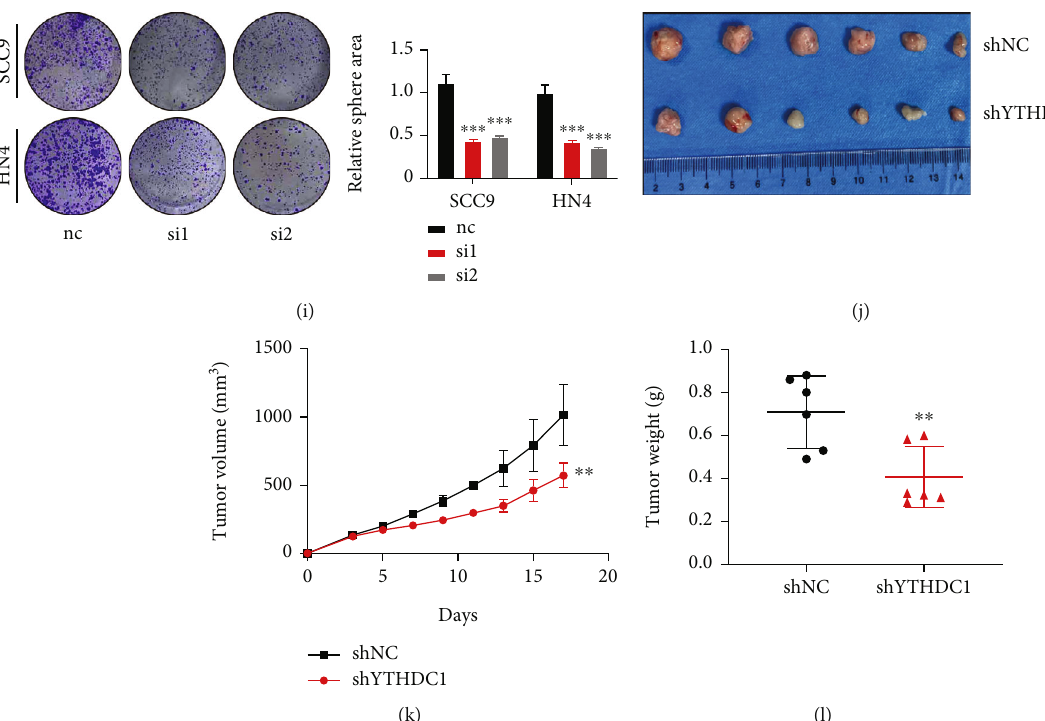
Figure 4: Inhibition of the YTHDC1 expression signi fi cantly limits tumor cell stemness maintenance, migration, and proliferation. (a) Western blotting of YTHDC1 in six HNSCC cell lines. (b) Western blotting of YTHDC1 in SCC9 and HN4 with or without YTHDC1 knockdown. (c) qPCR data of YTHDC1 in SCC9 and HN4 with or without YTHDC1 knockdown. (d) SOX2 and BMI1 protein expression in SCC9 and HN4 with or without YTHDC1 knockdown. (e) The OCT4 and NANOG protein expression in SCC9 and HN4 with or without YTHDC1 knockdown. (f). SCC9 and HN4 cell proliferation ability was suppressed after the YTHDC1 expression was decreased. (g) Sphere formation ability of SCC9 and HN4 cell lines was inhibited after the YTHDC1 expression was suppressed. (h) Representative images and quanti fi cation of migration assay of SCC9 and HN4 cell lines with or without YTHDC1 knockdown. (i) Representative images and quanti fi cation of colony formation assay of SCC9 and HN4 cell lines with or without YTHDC1 knockdown. (j). Tumor xenograft experiment in nude mice detects the e ff ect of YTHDC1 on tumor growth in vivo ( n = 6 in each group). (k) Tumor growth curve. The quantitative value of tumor volumes is plotted, and tumor volumes are measured once two days after injected. (l) Scatter diagram shows tumor